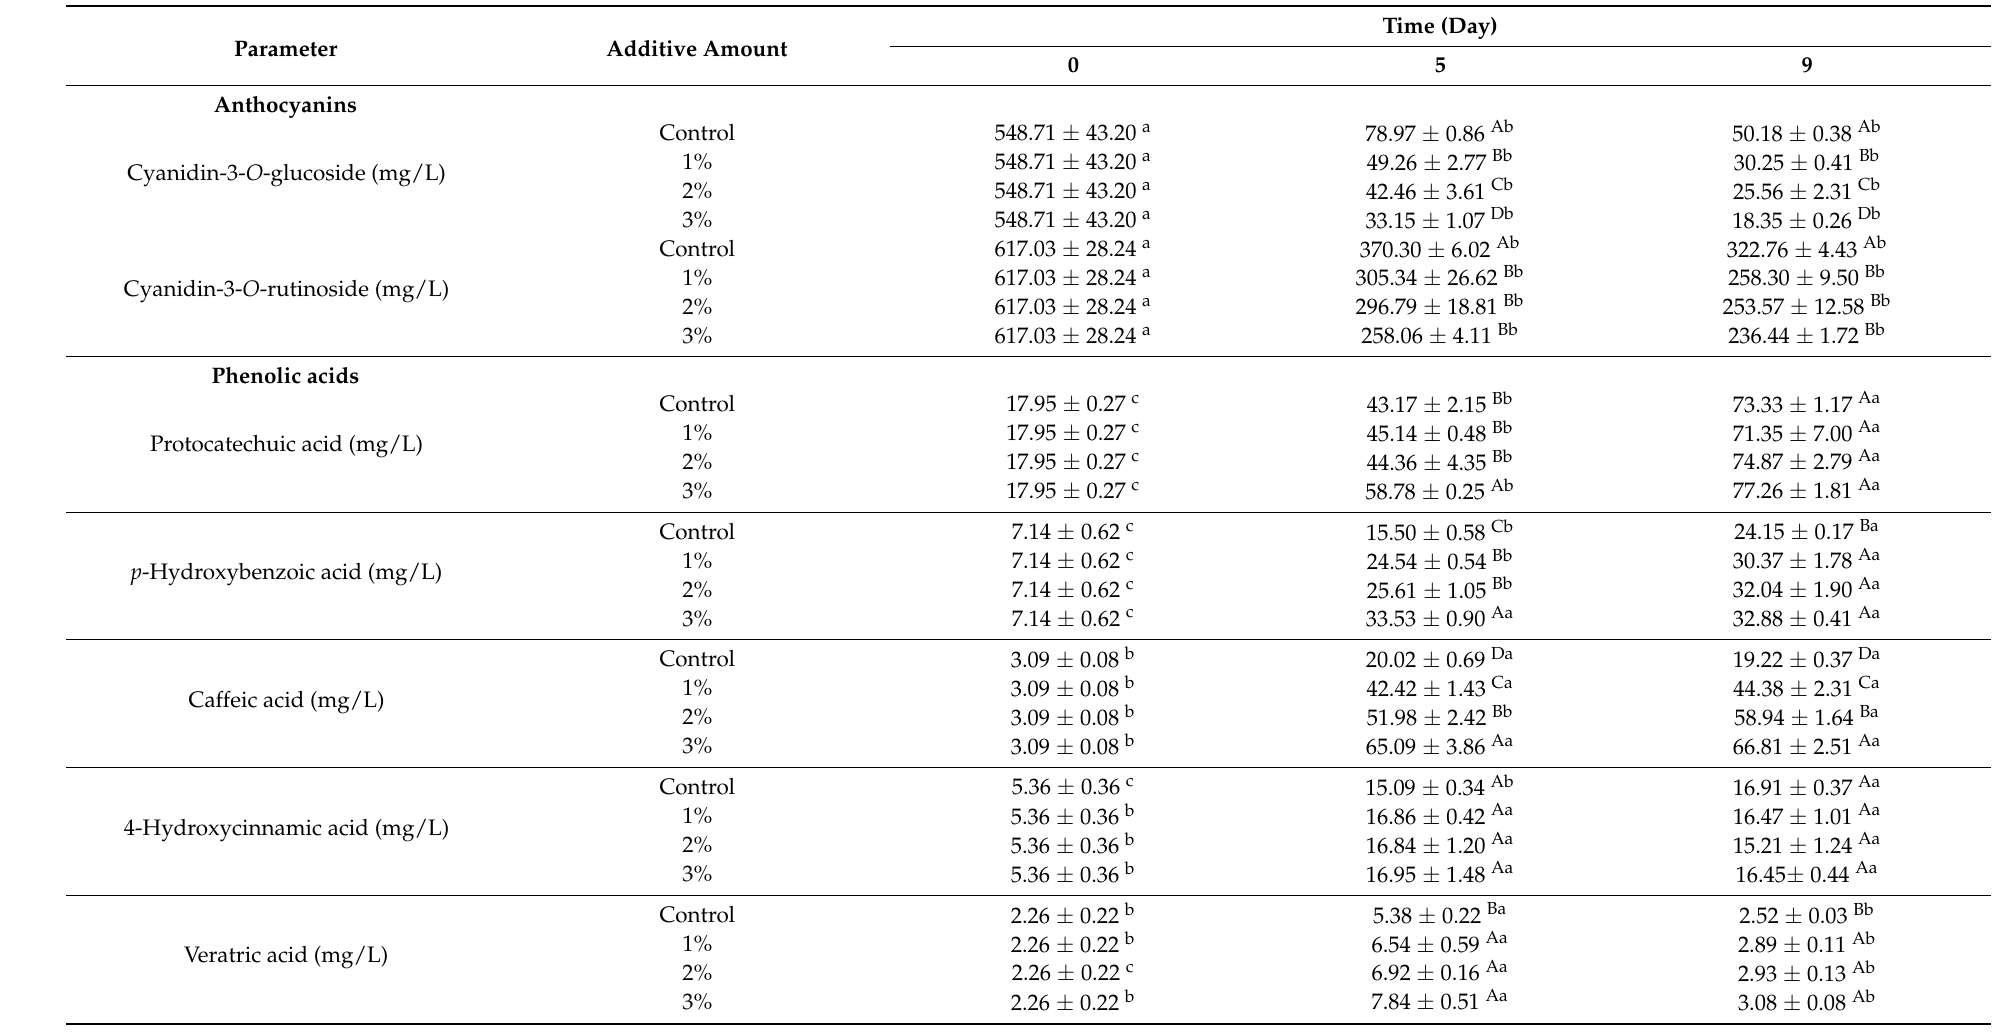
Table 3. Contents (mg/L) of individual phenolic compounds in mixed mulberry fruit and mulberry leaf fermented alcoholic